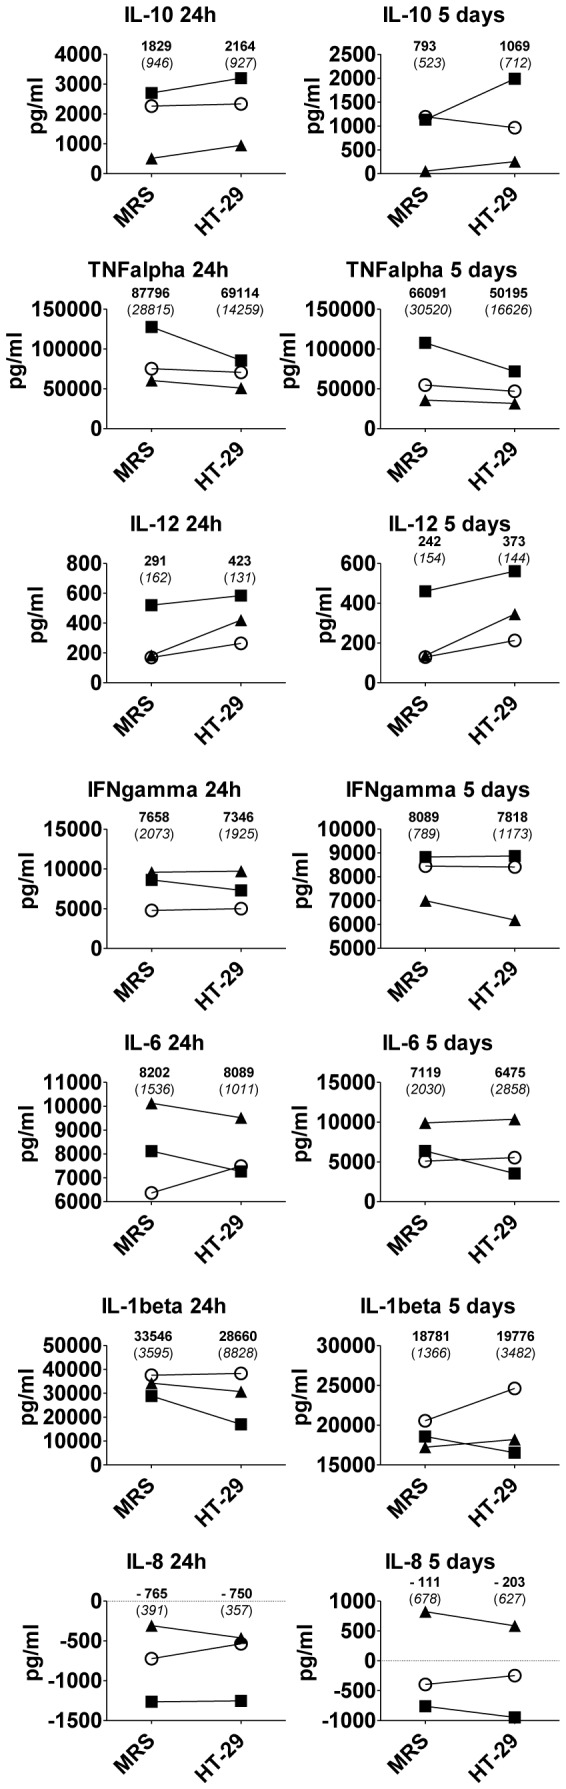
Effect of Lactobacillus casei ATCC 334 on production of a cytokine panel in PBMC.Bacteria were pre-cultivated in the presence of HT-29 intestinal epithelial cells or in MRS broth, and then co-cultured with human PBMC (n = 3 donors). After 24 hour and 5 day co-culture, conditioned media from the cells were collected and the amounts of indicated cytokines were determined by Human FlowCytomix kit. Background values (cytokine production in PBMC incubated in the absence of bacteria) were subtracted from the values. Cytokine production in each individual PBMC preparation is shown separately (squares, donor 1; circles, donor 2; triangles, donor 3). Averages (and standard deviations) of cytokine production in the three PBMC preparations are indicated. The data from 24 hour time-point originates from two technical replicates, and the data from 5 day time-point from one technical replicate of each PBMC.